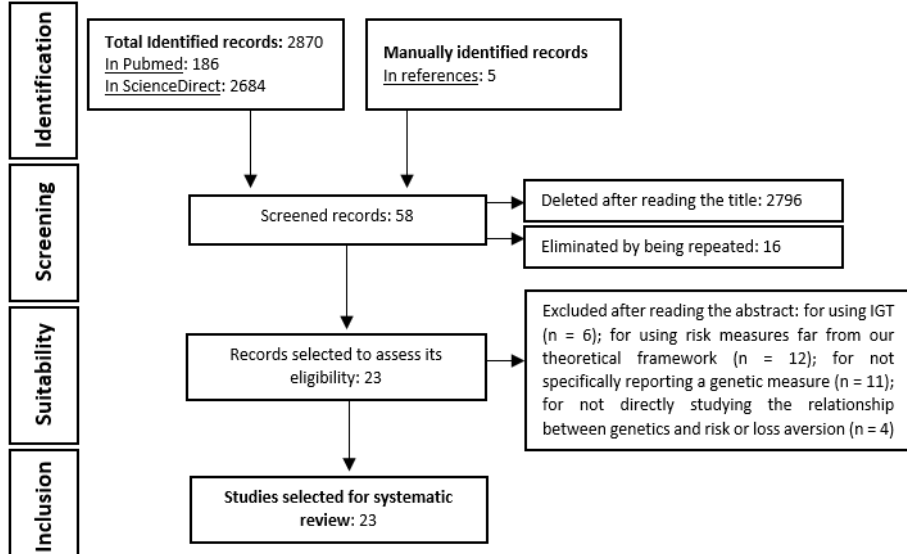
Figure 1. Revision Figure 1. Revision flowchart.